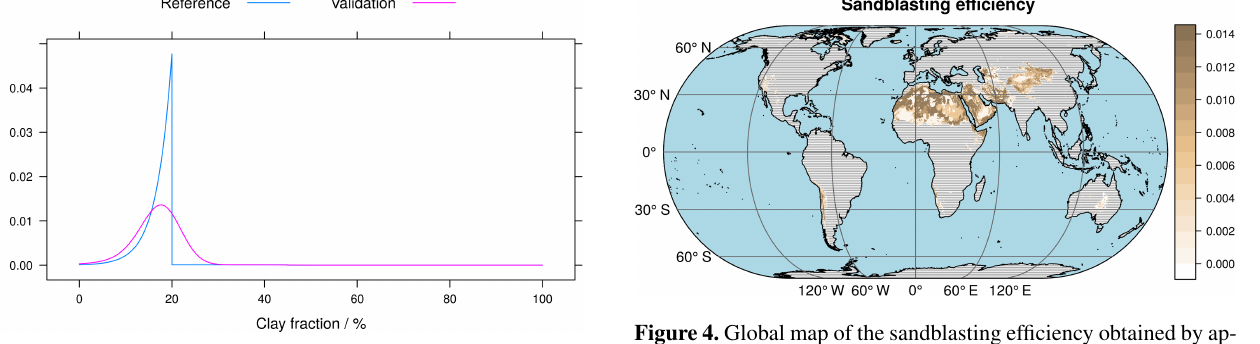
Figure 3. The sandblasting efficiency as function of the clay frac- tion used by Astitha et al. (2012), before (“reference”) and after (“validation”) applying a Gaussian filter with an interquartile range of 5%.